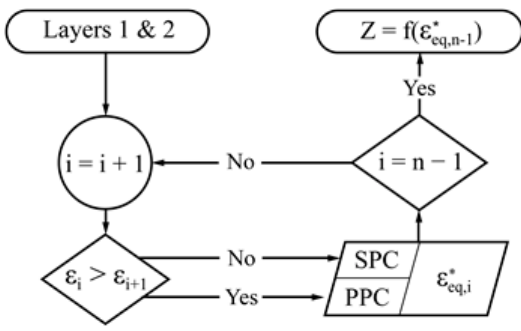
Figure 3. Iterative method to derive the analytical bioimpedance model.